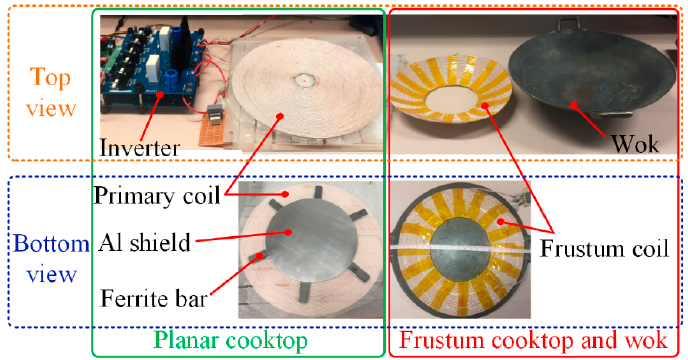
Figure 12. Construction of the prototype.